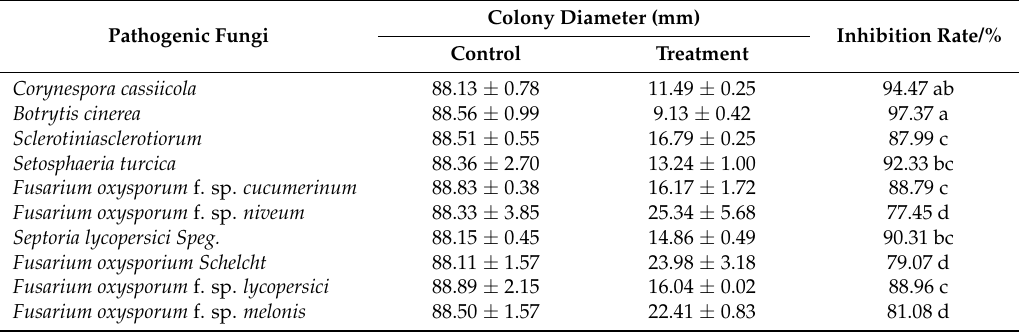
Table 5. Inhibitory effect of strain WXCDD105 on plant pathogenic fungi.